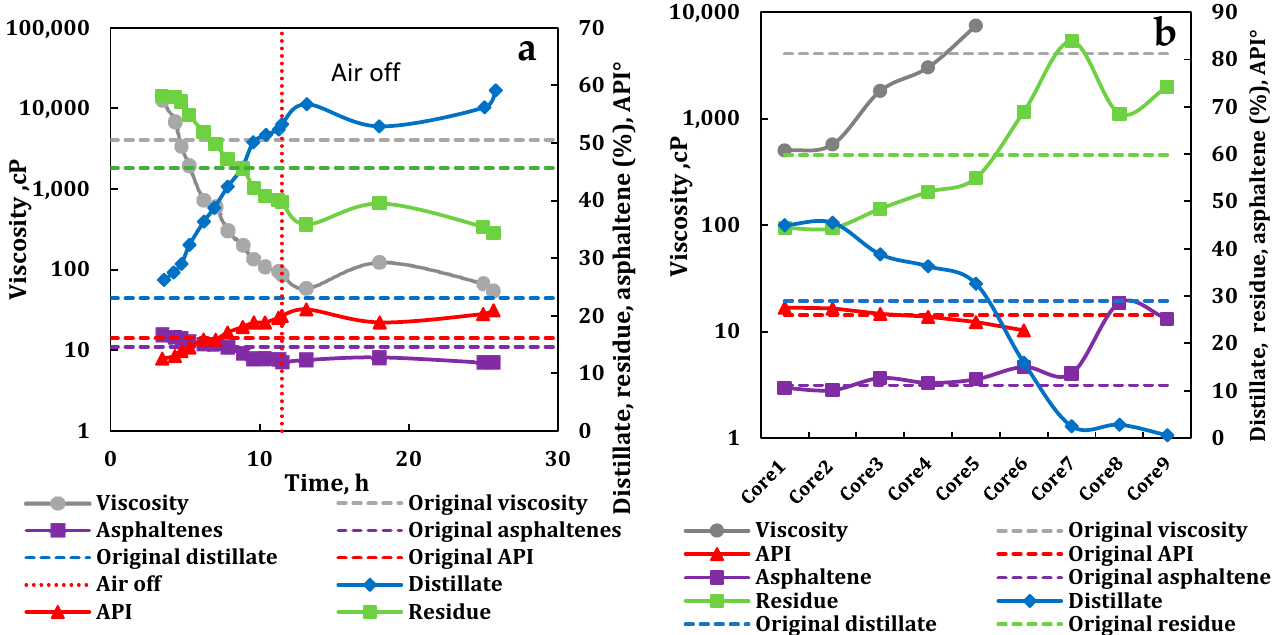
Figure 19. Properties of ( a ) the produced oil and ( b ) the oil extracted from the post-test core. Due to the insufficient amount of extracted oil, viscosity and API gravity measure- ments of some of the extracted samples were not possible. The produced oil samples and the extracted residual oil samples demonstrated a slight change in the values of H and S, while the rest of the elements (except for O) presented a stable mass fraction throughout the run (Figure 20). The oxygen mass noticeably reduced between 7.0 and 8.8 h, slowly increasing towards the end of